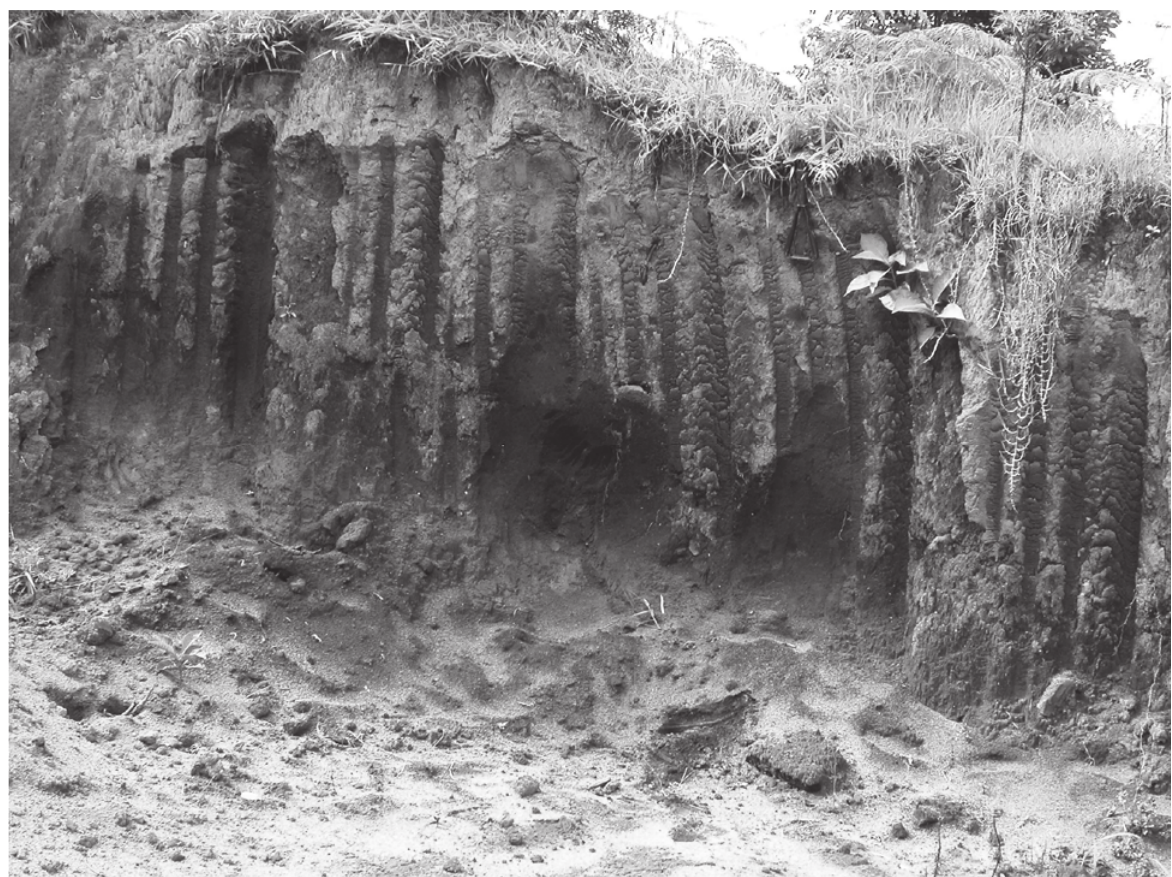
Figure 11 - Young colluvial soil over a dark charcoal horizon, municipality of Nova